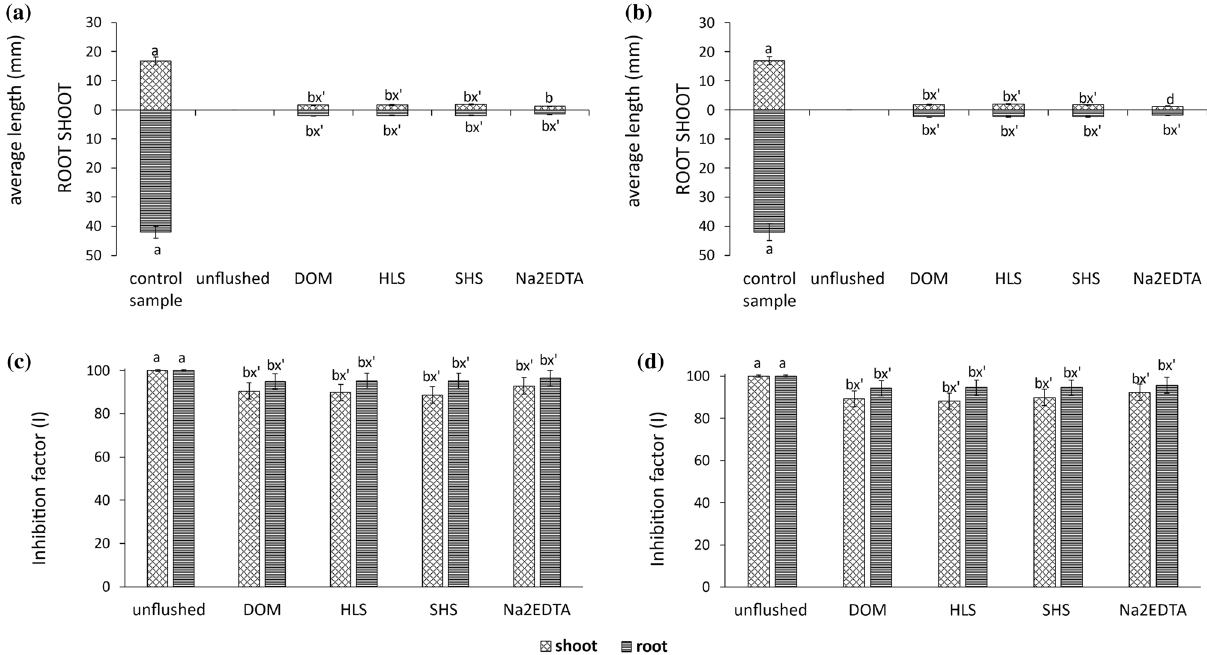
Figure 5. Changes in the lengths of wheat shoots and roots with inhibition factor (I) in soil before and after flushing with DOM, HLS, SHS and Na 2 EDTA: 0.5 ml/min ( a , c ), 1.0 ml/min ( b , d ). As a control sample, the unspiked soil was used. Small letters (ab) indicate statistically significant differences between the unflushed and flushed soils, the symbol x’ or y’ indicates no significant differences between tested